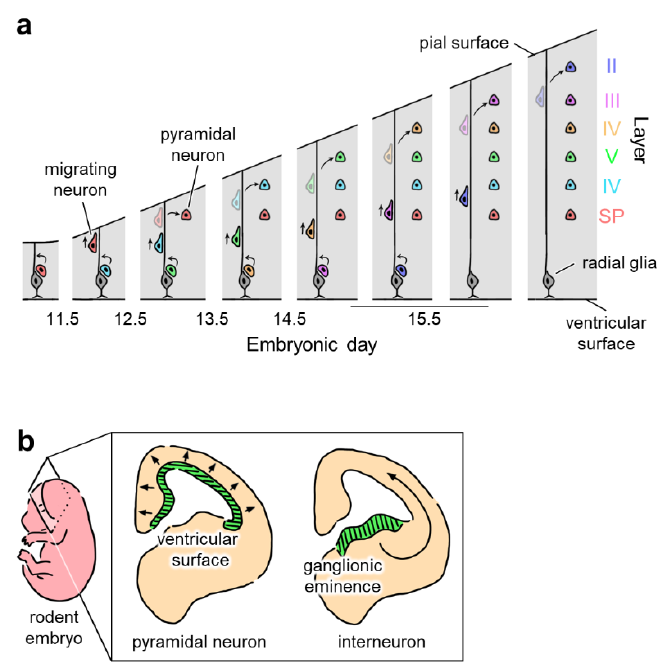
Figure 4. Region- and cell type-specific in utero electroporation by targeting precursor cells. ( a ) Inside-out scheme of neuronal migration (indicated by arrows) in the developing neocortical layers. The pyramidal neurons in deep layers of the cortex form earlier than pyramidal neurons in superficial layers. Pyramidal neurons in cortical layers II, III, IV, V, and VI and the subplate (SP) are indicated in blue, pink, yellow, green, light blue, and red, respectively. Radial glial cells in the ventricular zone are indicated in gray. Newborn neurons migrate into the cortex using radial glia spanning from the ventricular to the pial surface. Expression of foreign genes in a specific cortical layer can be achieved by in utero electroporation targeting newly born neurons that mature into pyramidal neurons in the target layer. ( b ) Origins of pyramidal neurons and interneurons. Pyramidal neurons generated in the ventricular surface (middle, green) migrate radially (in the direction of arrows), while interneurons originating from the ganglionic eminence (right, green) migrate tangentially (in the direction of a curved arrow). Thus, ganglionic eminence-targeting in utero electroporation allows for the interneuron-selective expression of foreign genes.